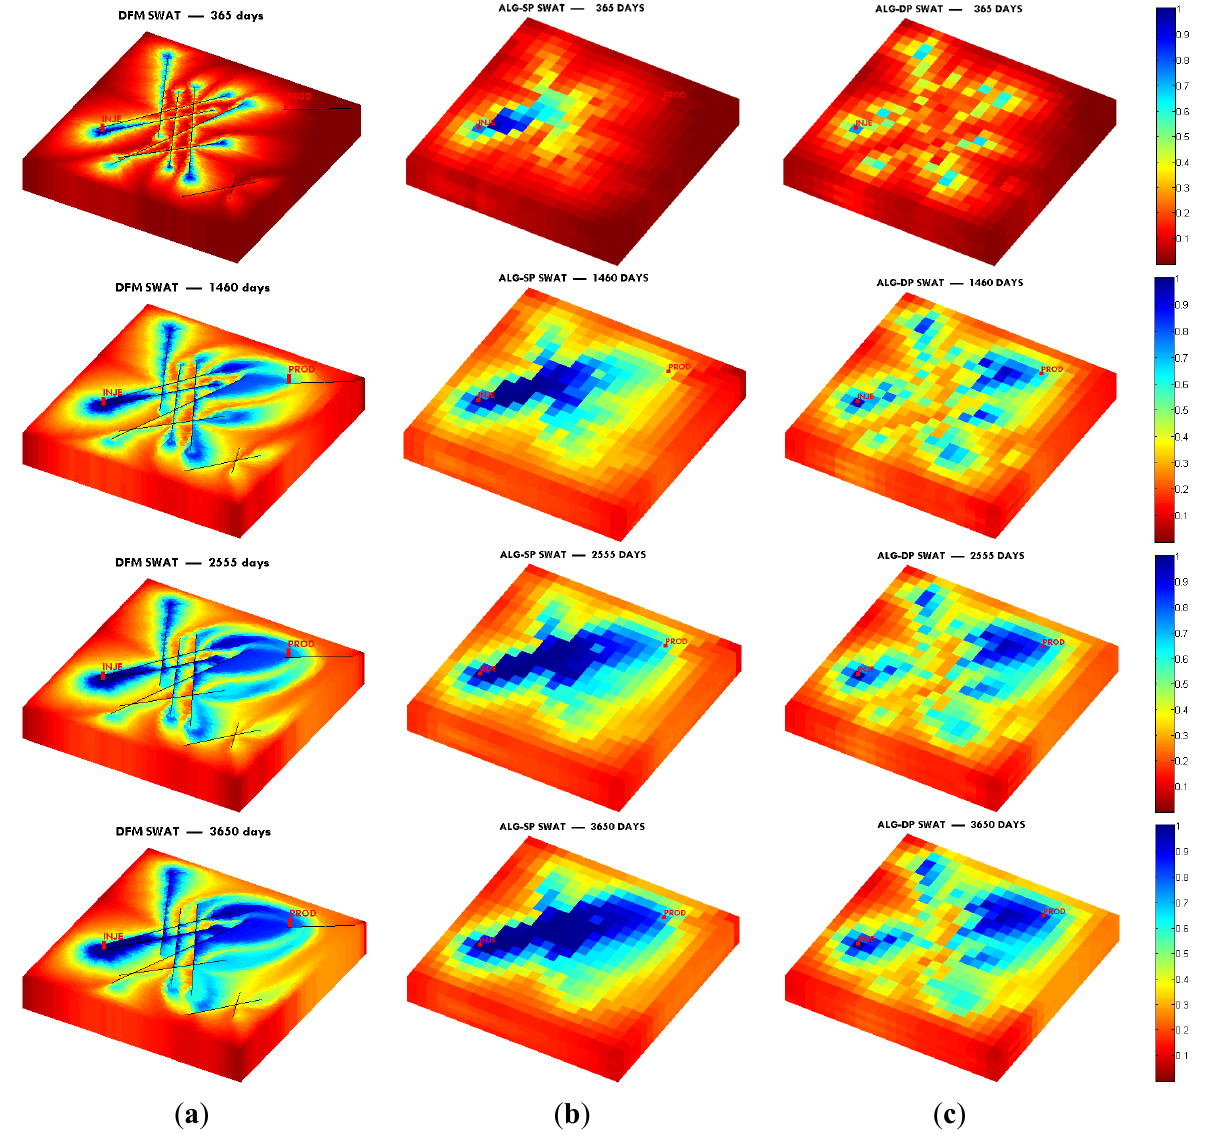
Figure 12. Water saturation fields for case 2 at 365/1460/2555/3650 days. ( a ) DFM fine model; ( b ) ALG-SP coarse model; ( c ) ALG-DP coarse